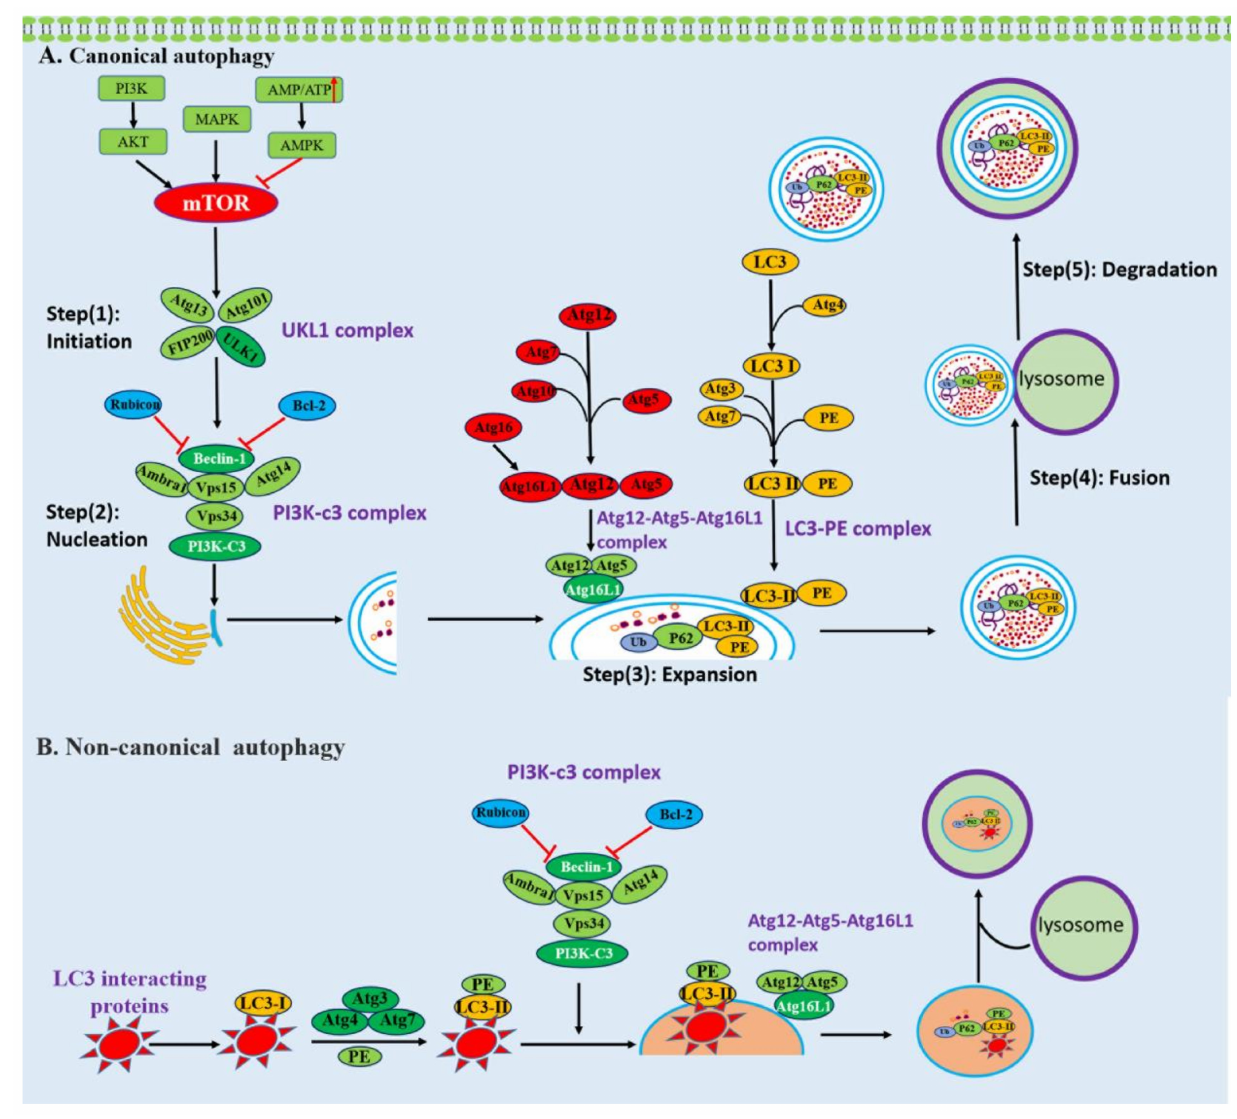
Figure 2. Schematic presentation of canonical and non-canonical autophagy. ( A ) The process of canonical autophagy. Canonical autophagy can be roughly divided into five steps: (1) initiation, (2) nucleation, (3) expansion, (4) fusion, (5) degradation and is mediated by Atg family proteins, kinases, and lipid metabolism. ( B ) The process of LAP-like non- canonical autophagy. LAP-like non-canonical autophagy is initiated by autophagy receptors through their LIR interacting with LC3. LC3 is recruited to single-membrane phagosomes. LAP-like non-canonical autophagy is independent of the upstream autophagy regulators mTOR and ULK1 initiation complex, while it needs the class III PI3KC3 complex and members of the protein lipid conjugation